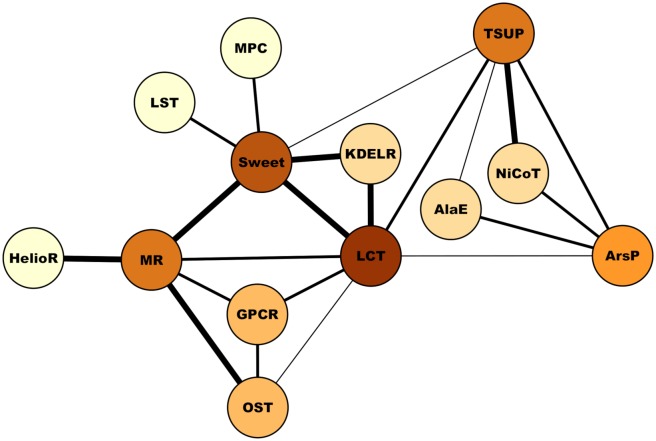
Network of relationships within the TOG superfamily.Nodes represent all families in TOG used in this study. The darker the color of a node the more connections that family has to other families. The relative confidence level (i.e., high, medium or low) of the homology assignment between two families is expressed with three levels of thickness of the edges connecting pairs of nodes; the thickest lines corresponding to the connections of highest confidence. See Methods and S3 Table for how the confidences levels where defined.